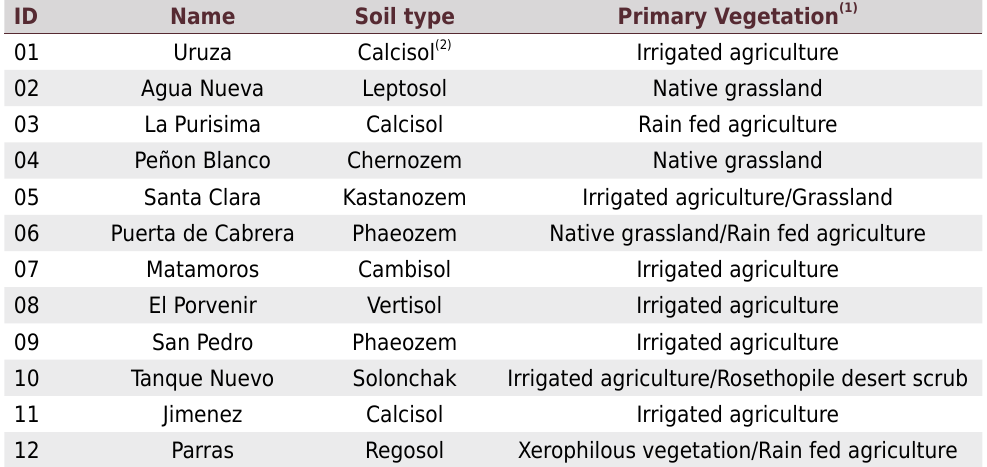
Table 1. Soil type and vegetation within the study area